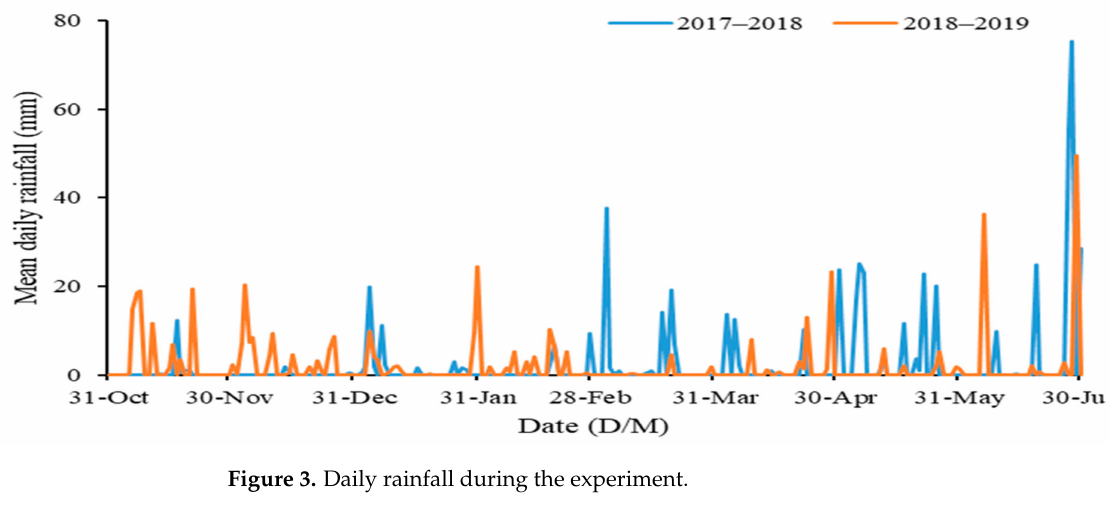
Figure 3. Daily rainfall during the experiment.